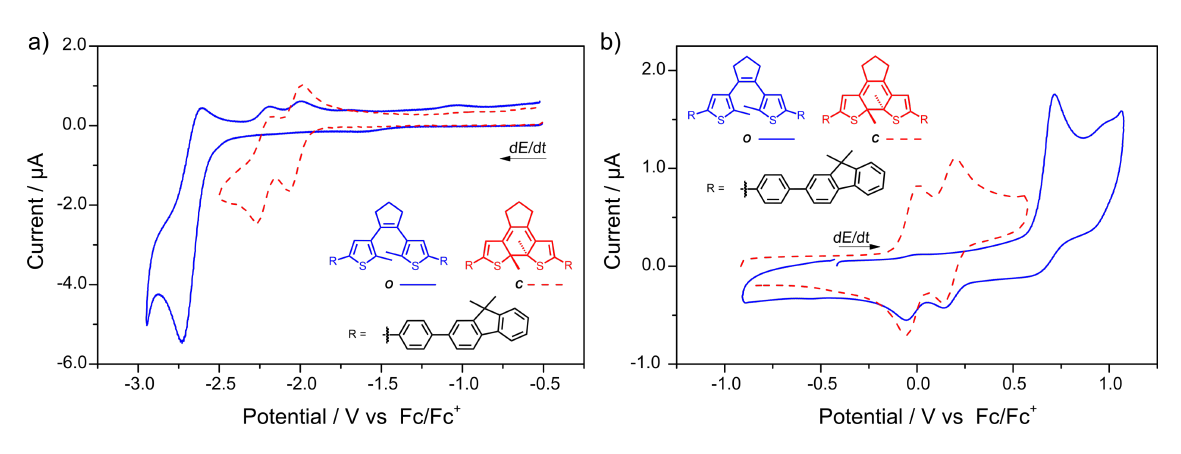
Figure 5: Cyclic voltammogram of DTE-PhFluorene . The ring-closed isomer (red dashed line) is formed both under a) reductive and b) oxidative conditions from O -DTE-PhFluorene (blue line), as shown by the emerging characteristic oxidation and reduction waves, respectively. Experiments in a) DMF with 0.1 M Bu 4 NPF 6 , c = 1 ∙ 10 − 3 M, dE / dt = 1 V s − 1 and b) DCM with 0.2 M Bu 4 NPF 6 c = 7 ∙ 10 − 4 M, dE / dt = 100 mV s − 1 . For two consecutive oxidation and reduction cycles, see Figure S25 in Supporting Information File